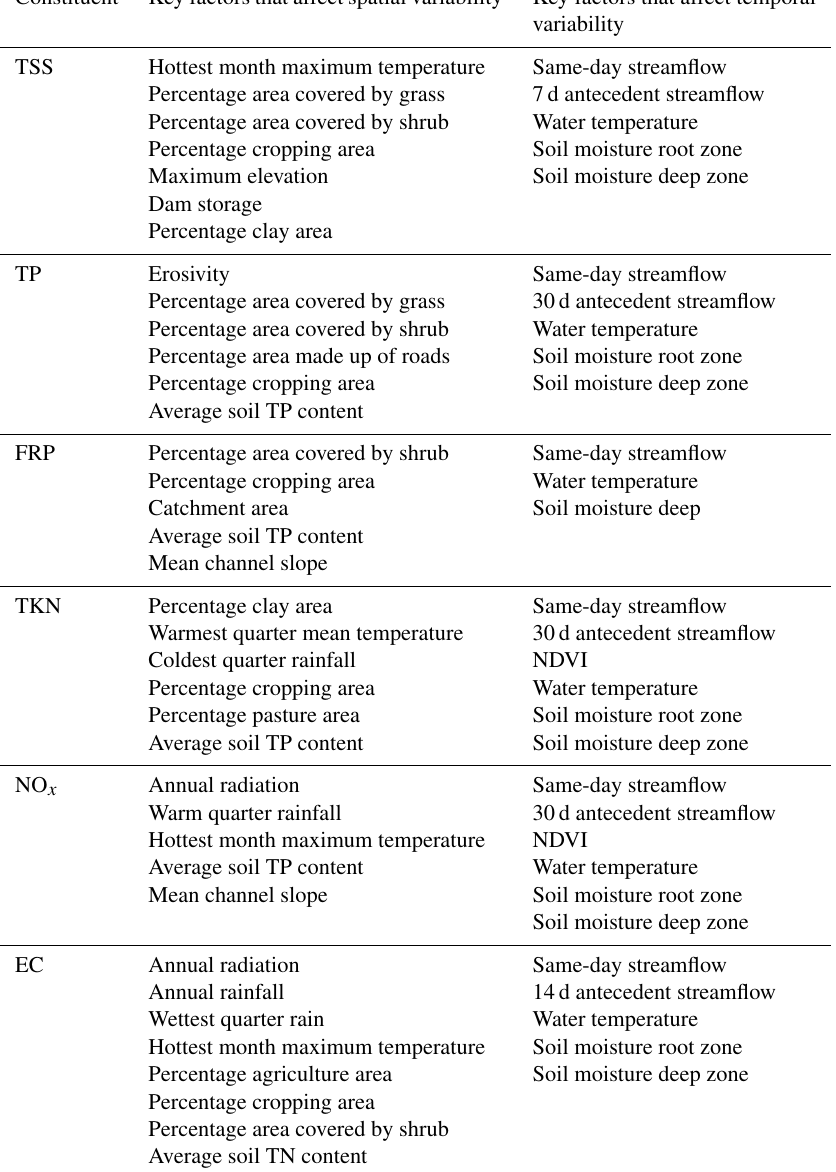
Table 1. Key factors affecting the spatial and temporal variability for each of six constituents, as identified in Lintern et al. (2018b) and Guo et al. (2019), respectively. Constituent Key factors that affect spatial variability Key factors that affect temporal